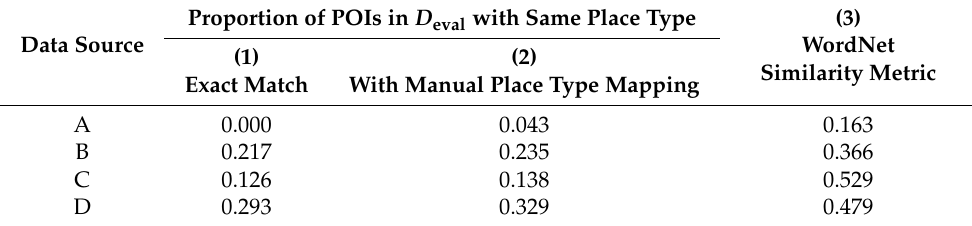
Table 4. Proportion of POIs with same place type using exact match, manual place type mapping, and WordNet similarity